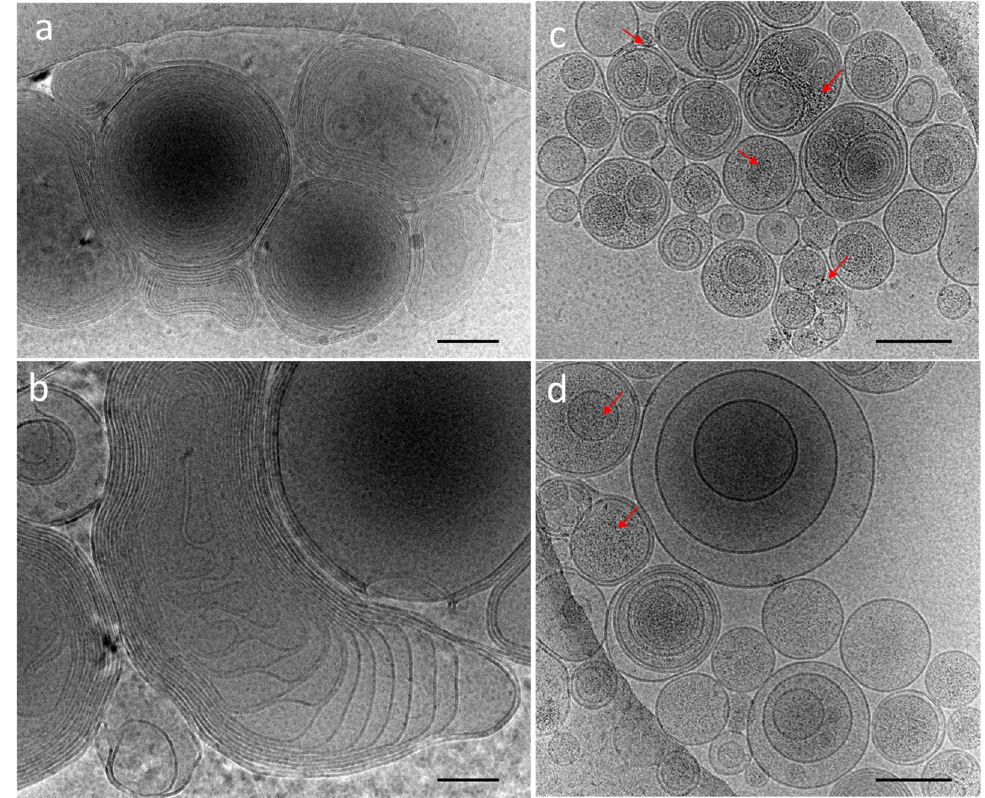
Figure 5. CryoTEM micrographs of DOPC MLVs’ ( a , b ) control without NCs and ( c , d ) in the presence of C 3 E 6 D Red NCs. The red narrows point out the presence of AuNCs. Scale bar represents 400 nm.